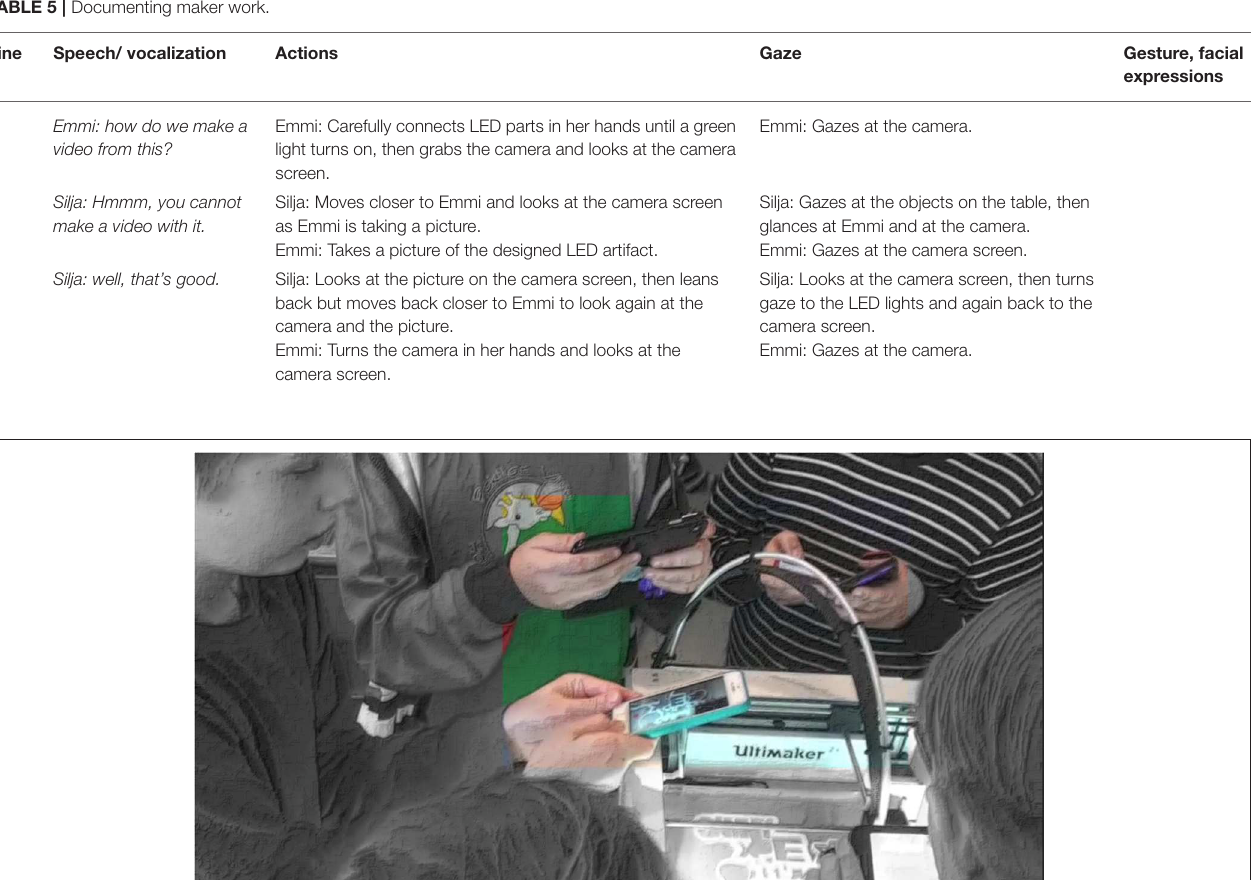
TABLE 5 | Documenting maker work.